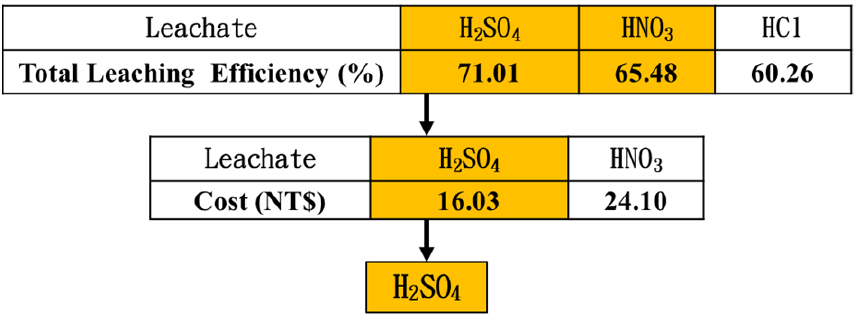
Figure 5. Optimal leachate selection.